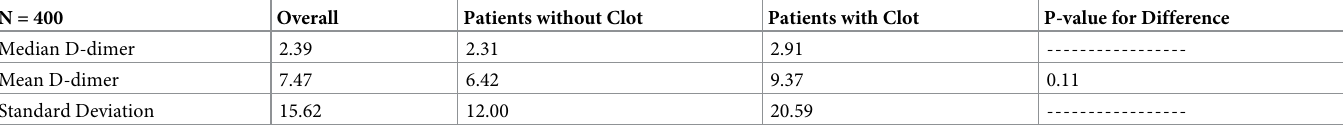
Table 6. Comparison of D-dimer levels in the first 48 hours of hospitalization between those with and without thrombosis who were admitted to the ICU. N = 400